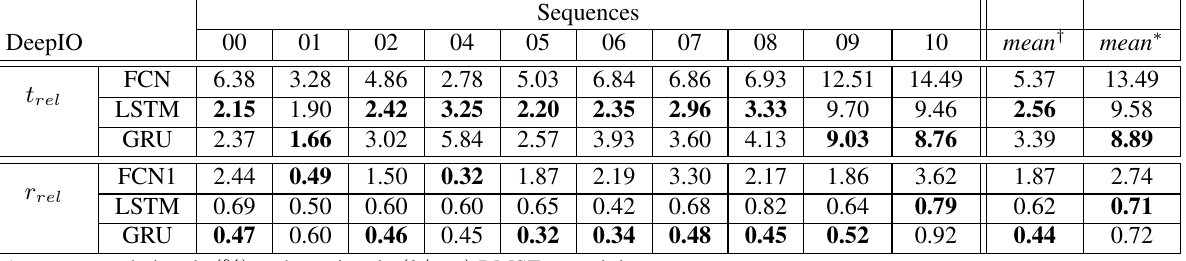
Table 1. Odometry results of DeepIO networks on KITTI dataset. Sequences